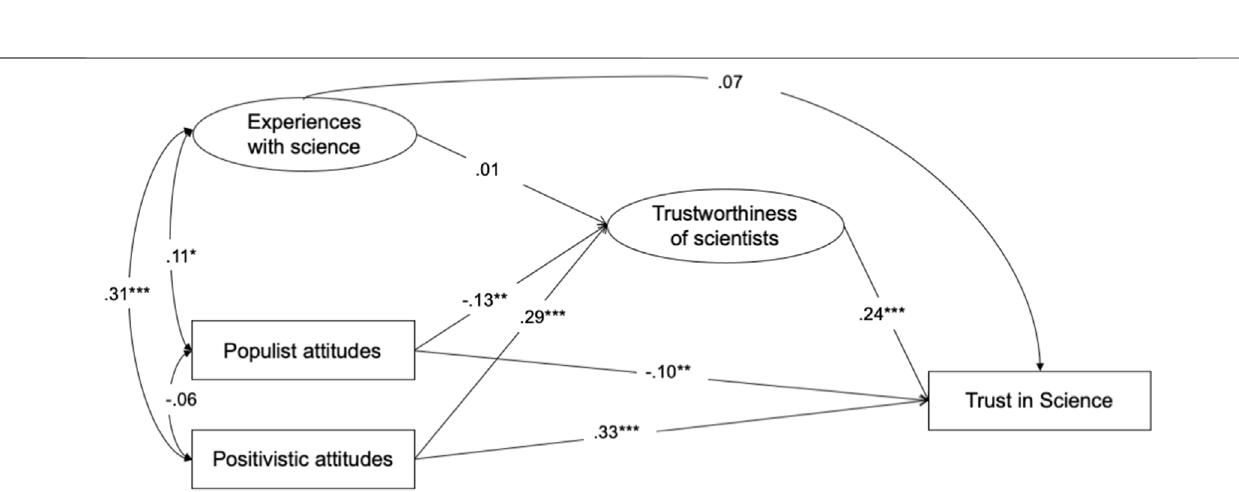
Frontiers in Communication |